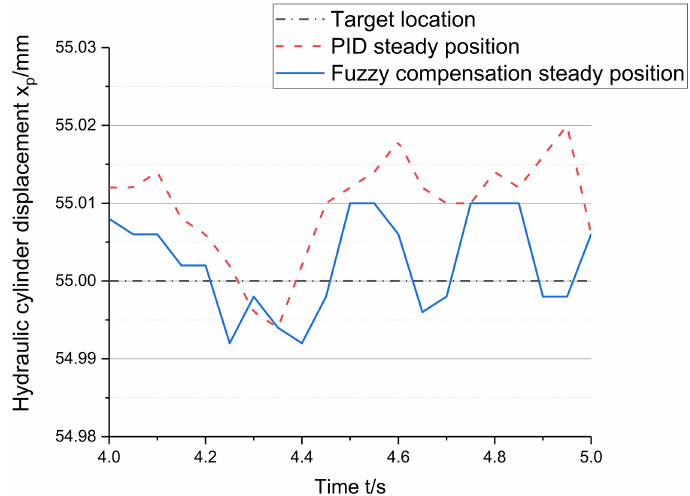
Figure 9. Local magnification curve of the extended position of the hydraulic cylinder.